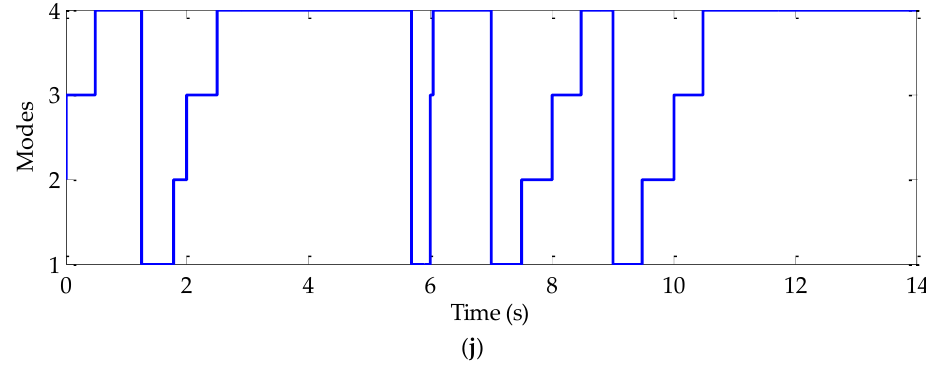
Figure 13 . Simulation results under extra urban drive cycle response: ( a ) radiation trajectory, ( b ) temperature trajectory, ( c ) street inclination angle, ( d ) wind speed, ( e ) PV generator power, ( f ) DC-link voltage, ( g ) vehicle speed, ( h ) load torque, ( i ) battery state of charge, and ( j ) operating modes.